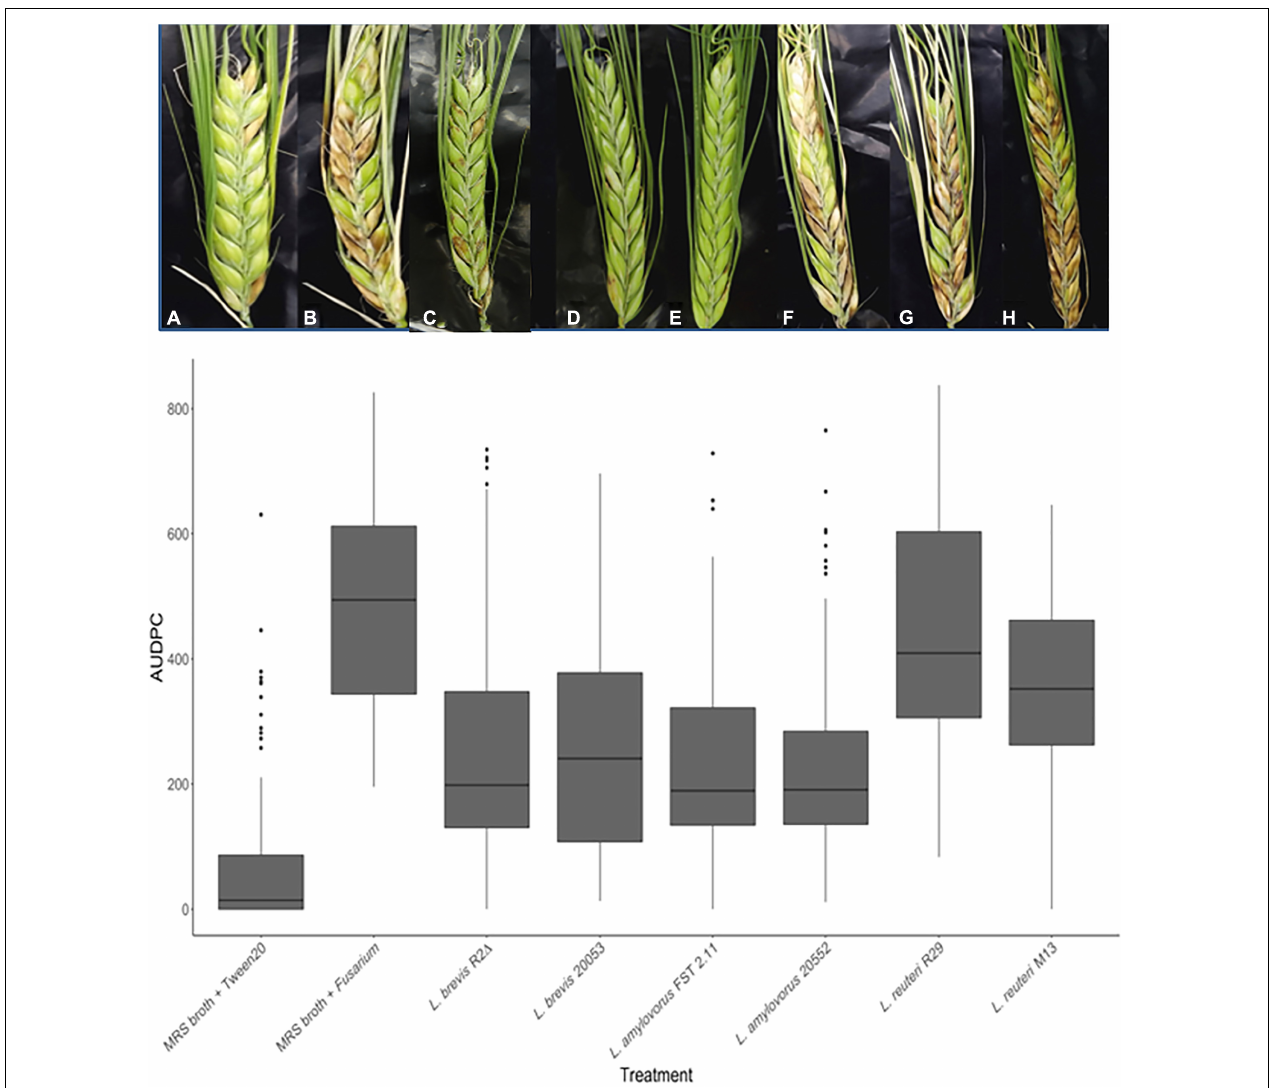
FIGURE 3 | FHB symptoms of spring barley cultivar “Sanette” assessed following LAB and control treatments at 14 days post-inoculation. Chosen spikelets received LAB [(C) ( L. amylovorus DSM 20552)], [(D) ( L. amylovorus DSM 20053)], [(E) ( L. brevis R2 (cid:49) )], [(F) ( L. amylovorus FST 2.11)], [(G) ( L. reuteri M13)], [(H) ( L. reuteri R29)] or MRS broth (A,B). Conidia of F. graminearum (B) or Tween 20 (mock) (A) were spray applied at mid-anthesis. Disease severity means were analyzed using the Kruskal–Wallis H test. * Indicates treatments significantly different from the control MRS broth + Tween 20. ** Indicates treatments significantly different